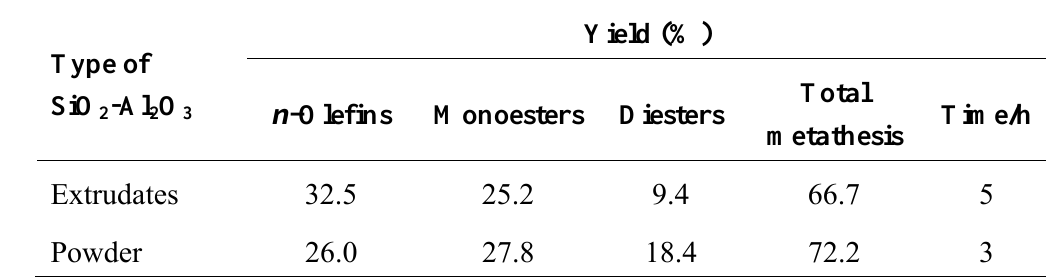
Table 3. Yield (in mol%) of products resulting from metathesis of FAMEs (derived